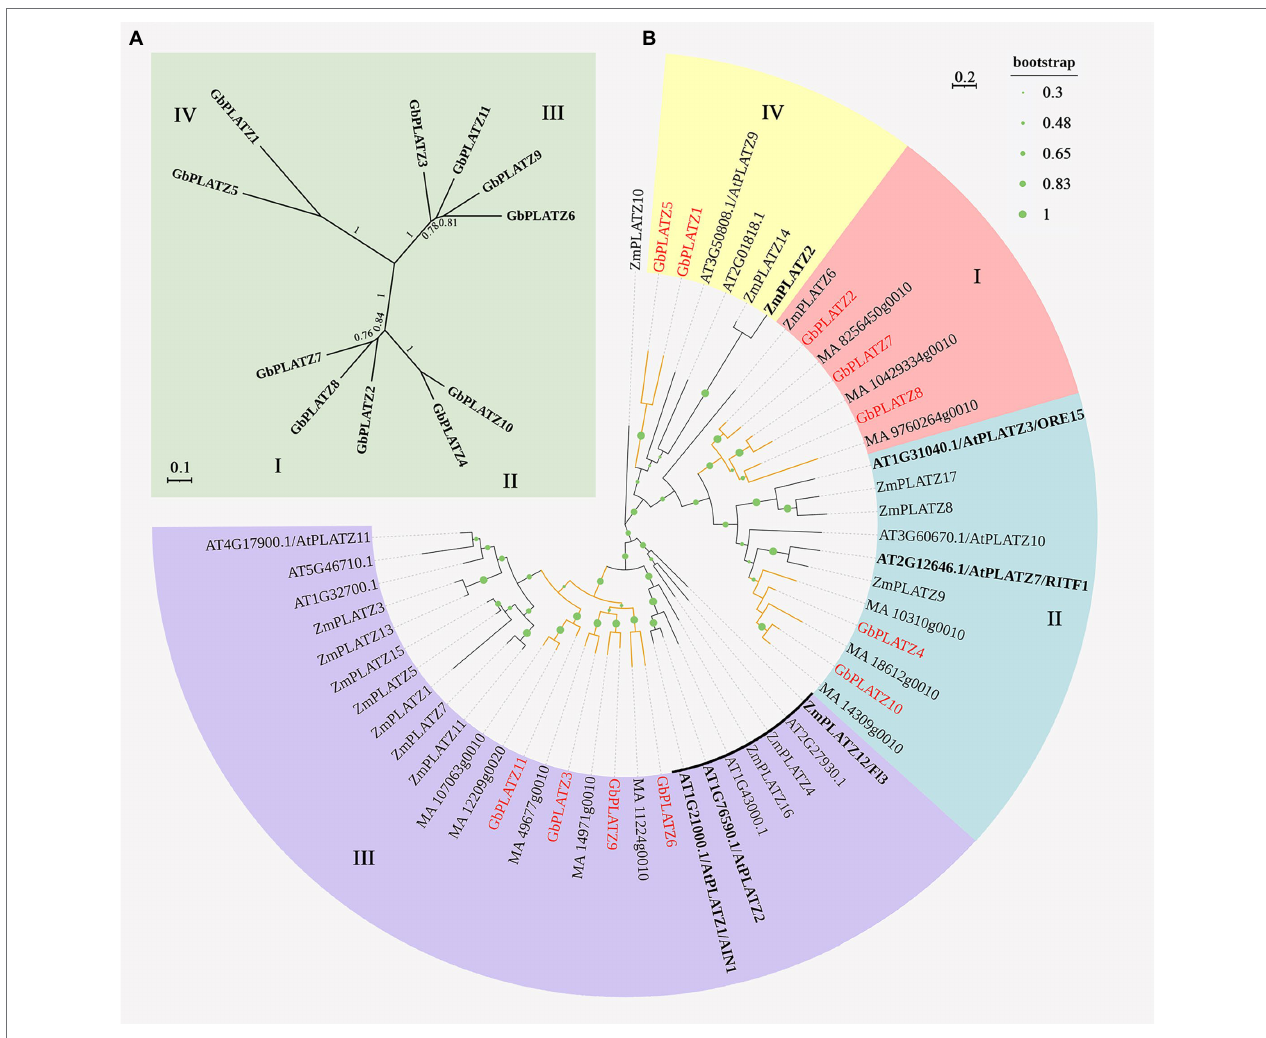
FIGURE 2 | Phylogenetic analysis of the GbPLATZ s. (A) Maximum likelihood trees of 11 PLATZ transcription factors in Ginkgo biloba . I–IV represents four categories based on phylogenetic topology. (B) Maximum likelihood tree for ginkgo (Gb), Norway spruce (MA), maize (Zm), and Arabidopsis (AT) PLATZ TFs, where GbPLATZ s and their branches are represented in red. The gymnosperms branches are highlighted in brown. The branch length is proportional to the rate of amino acid change. The size of a point on a branch represents the bootstrap value of the